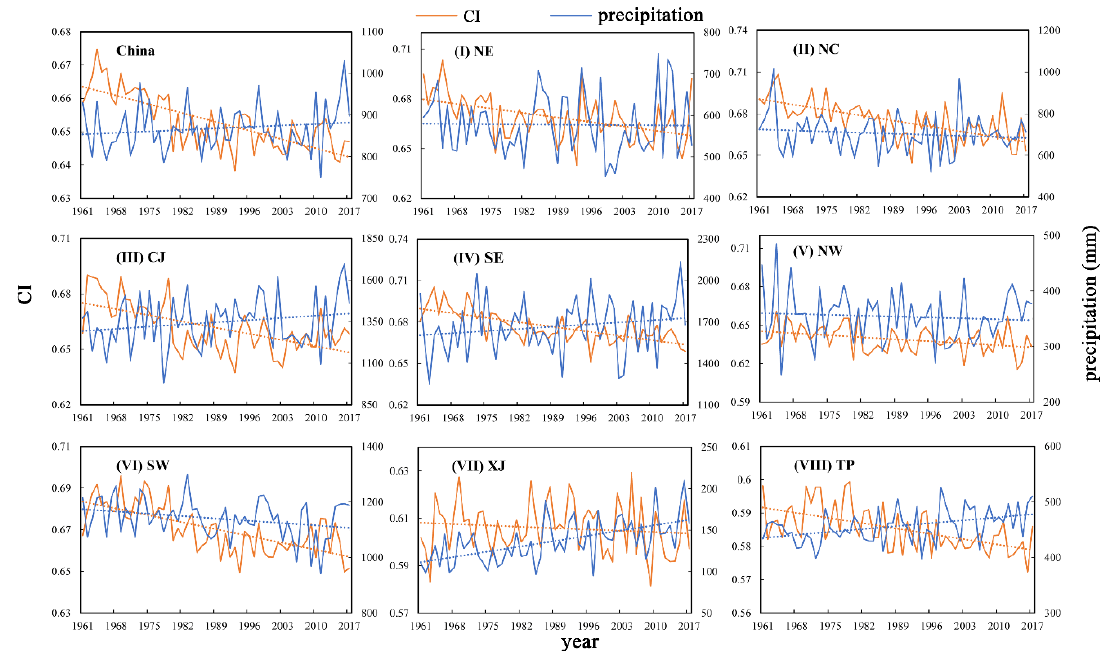
Figure 9. Time series of the annual precipitation (the blue solid line) and CI (the orange solid line) for eight subregions in China. The dashed lines are the corresponding linear trend.